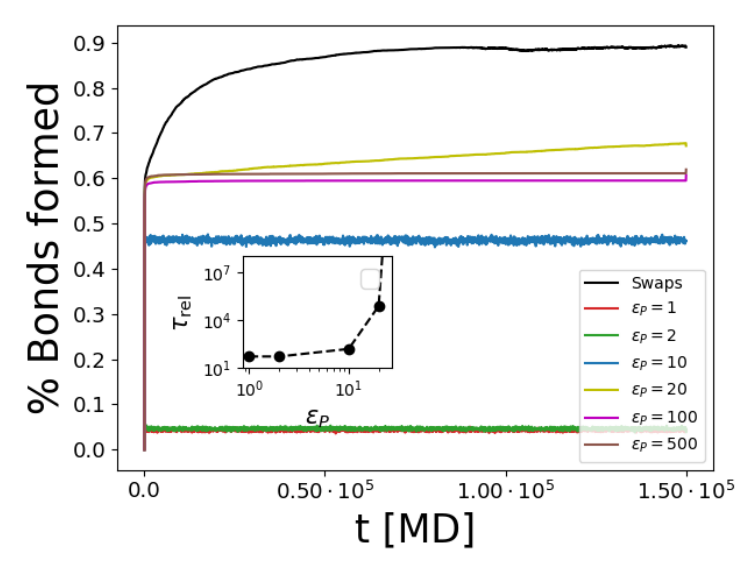
Figure 4: Percentage of bonds formed by the system introduced in sec. 3.2. The final stage of self-assembly corresponds to 100% bond formation. The non-swapping systems are trapped in pitfalls, so they are hardly forming new bonds. In the inset we show the characteristic time of the bond autocorrelation function τ . When bonds rel < 10) only few bonds occur at the same time. On the other hand, if are weak ( ε p > 10) the system cannot escape pitfalls because defects are the bonds are strong ( ε p long-lived. Bond swaps can be used to have strong long-lived bonds, which at the same time can relax away